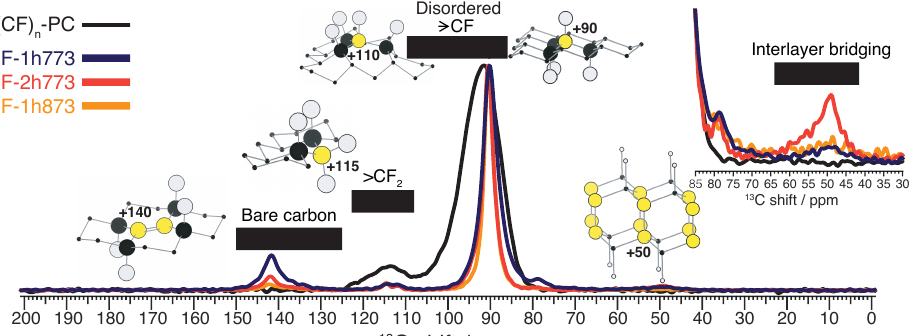
Figure 2. Reconstructed solid-state { 19 F } 13 C CP CPMG MAS NMR spectra of (CF) n -PC and the three GF samples. Spectra are scaled to the same maximum. Grayscale bars near the molecular models indicate approximate chemical shift ranges for the carbon atoms depicted in yellow of the associated models; these atoms are also numerically labeled by a representative 13 C chemical shift value. Black atoms, other C; bluish-white atoms,